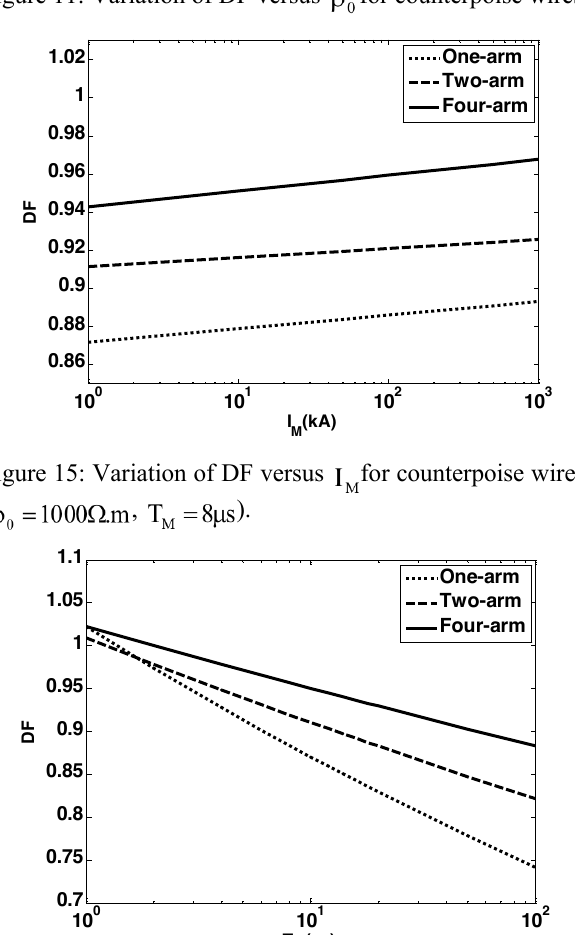
Figure 11: Variation of DF versus for counterpoise wires.